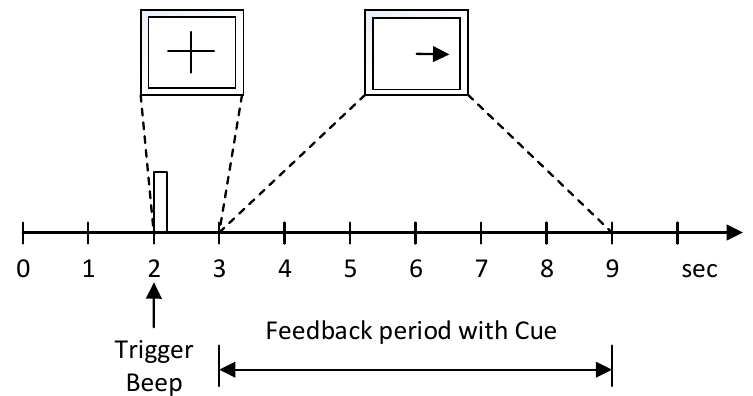
Figure 2. The paradigm of BCI competition II dataset III.